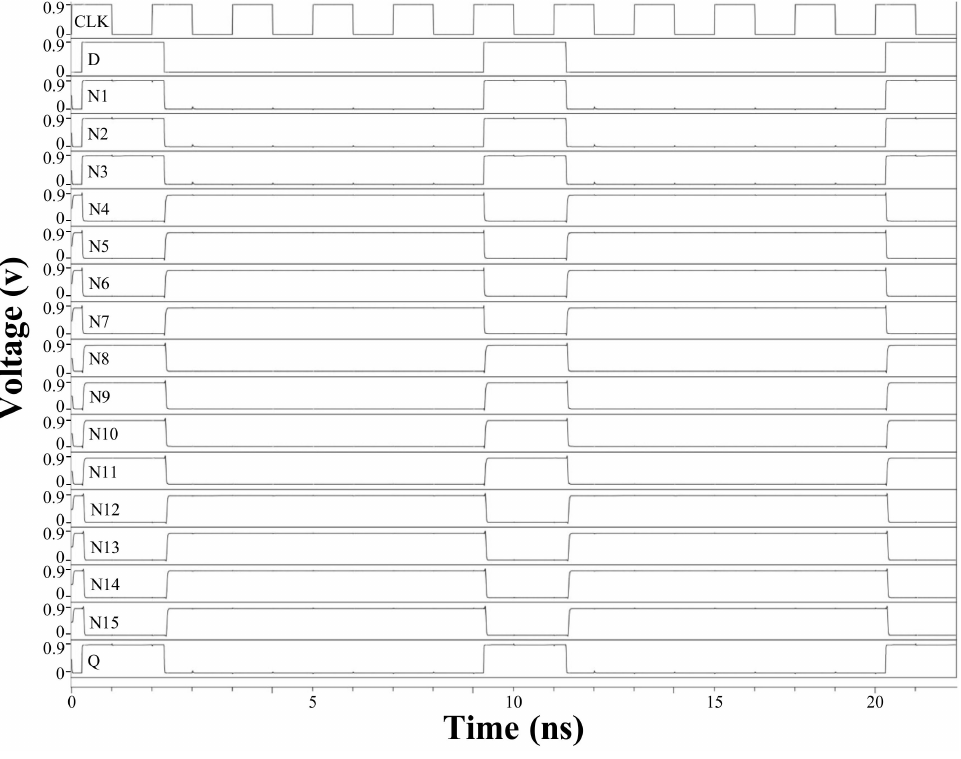
Figure 10. Simulation waveform of HTNURL